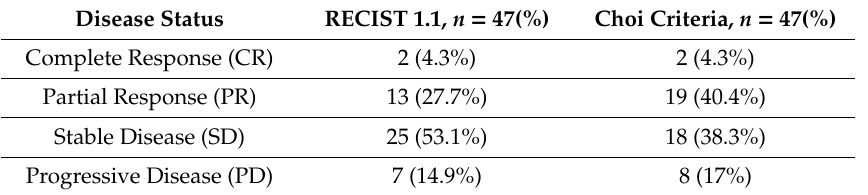
Table 3. Response rate based on RECIST 1.1 and Choi criteria.